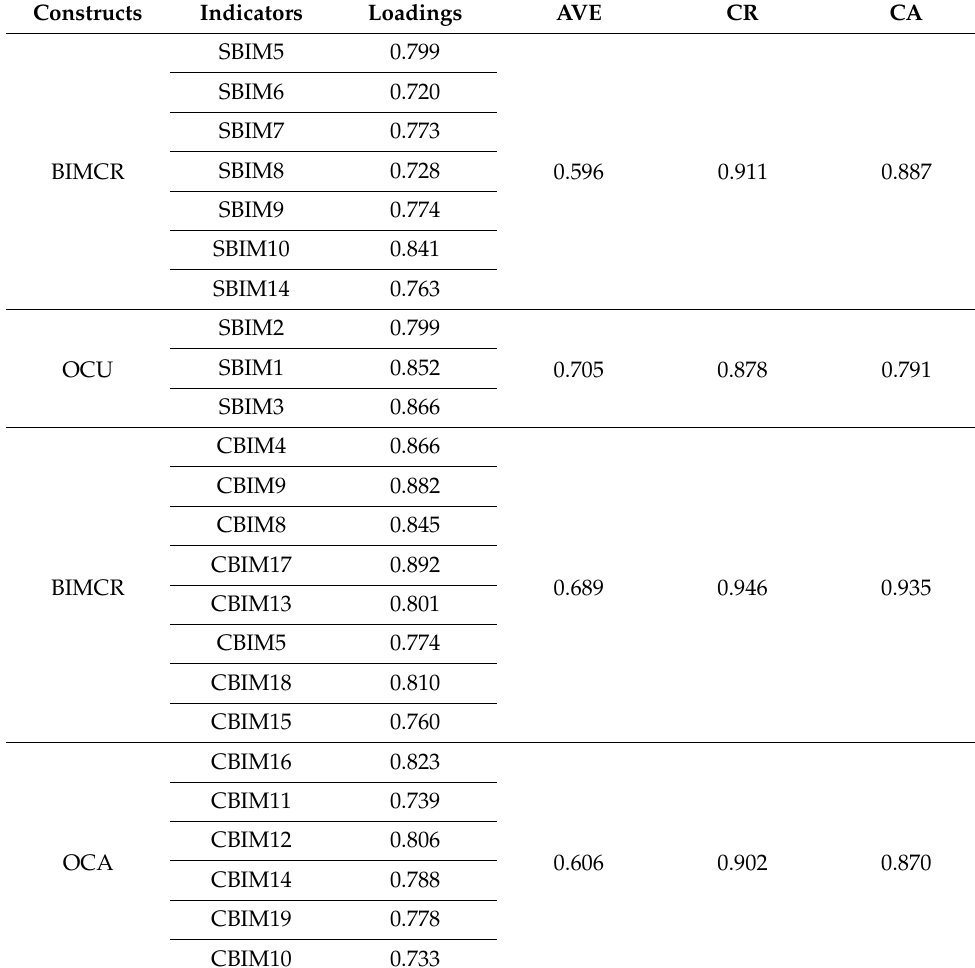
Table 6. Measurement model